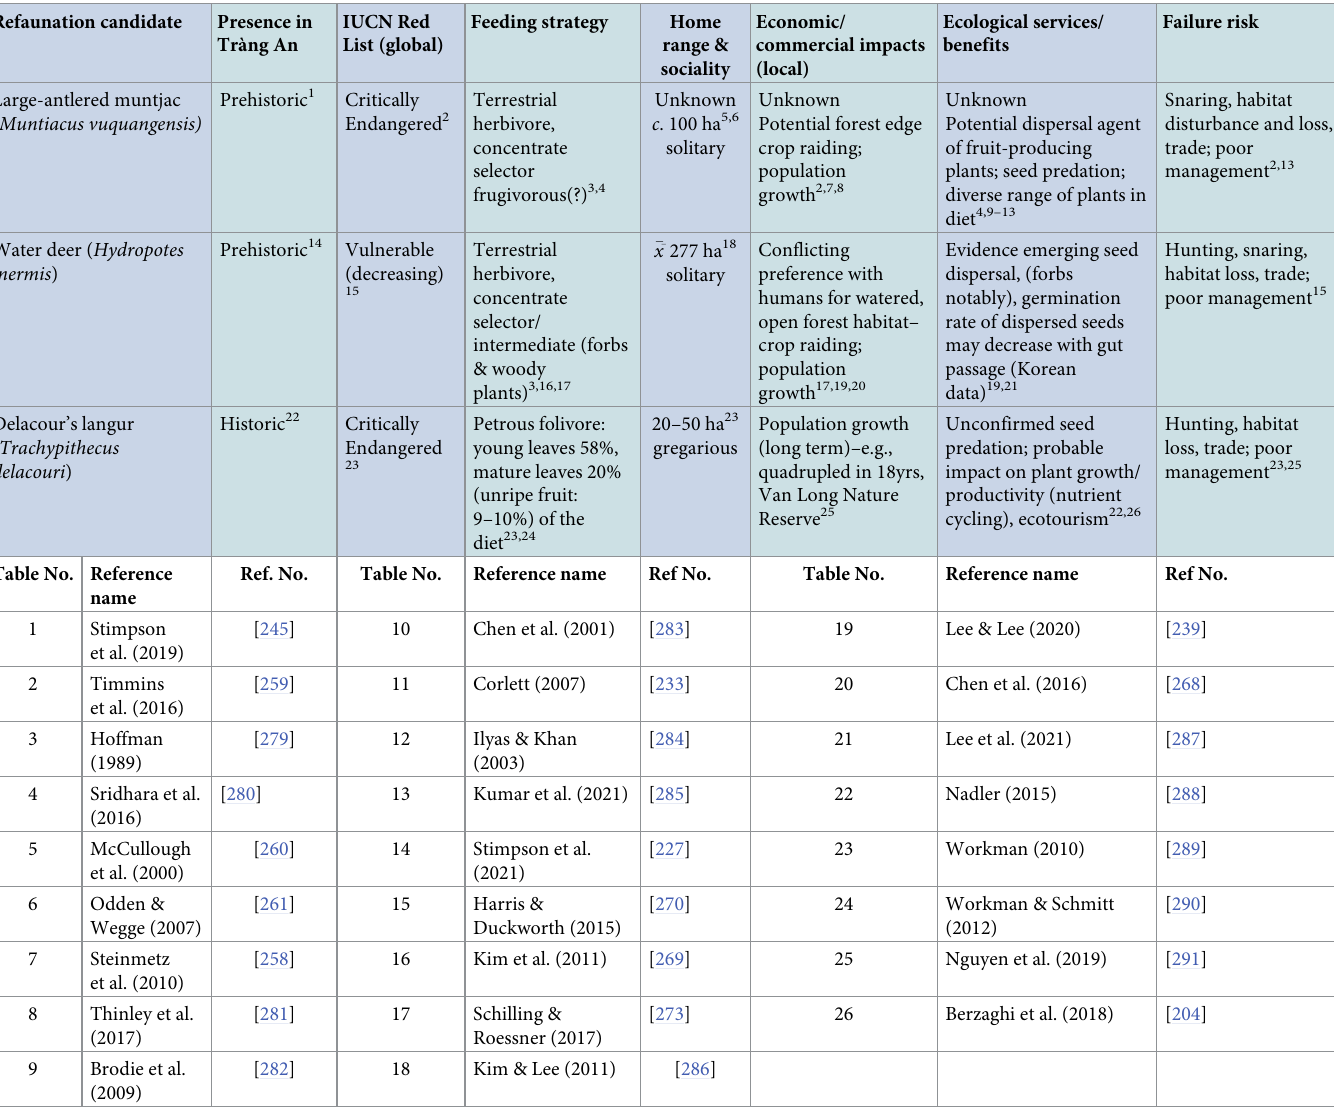
Table 2. Potential candidates for refaunation in the Tr à ng An Landscape Complex World Heritage Site. References pertaining to the large-antlered muntjac ( Muntia- cus vuquangensis ) are extrapolated from congeneric data but are as yet unconfirmed for this